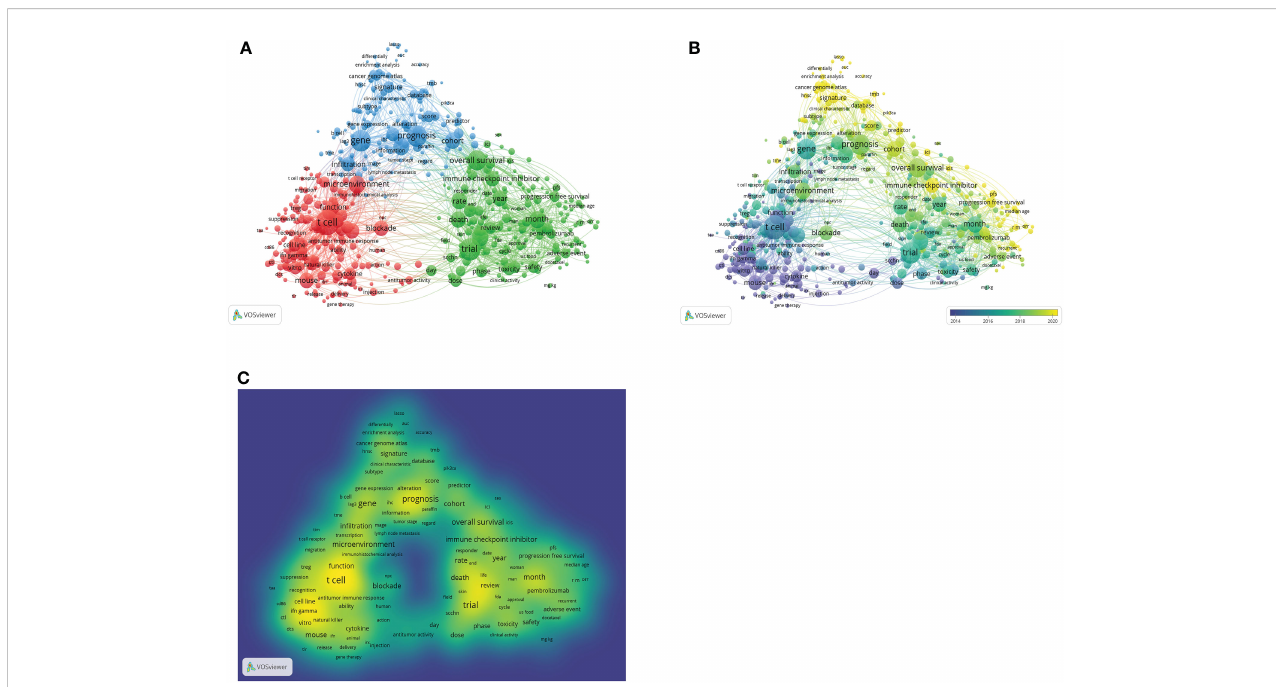
FIGURE 6 Bibliometric analysis of keywords in research papers on immunotherapy of HNSCC (A) Mapping of keywords in the HNSCC immunotherapy research. Thematic network maps of trends based on keywords used from January 2000 to December 2022 (B) . The indicator shows the current publication from purple to yellow. The size of the circle indicates the frequency of occurrence, and the distance between the two circles indicates the correlation between them. Keyword density map (C) . The most frequently used keywords are denoted by the color